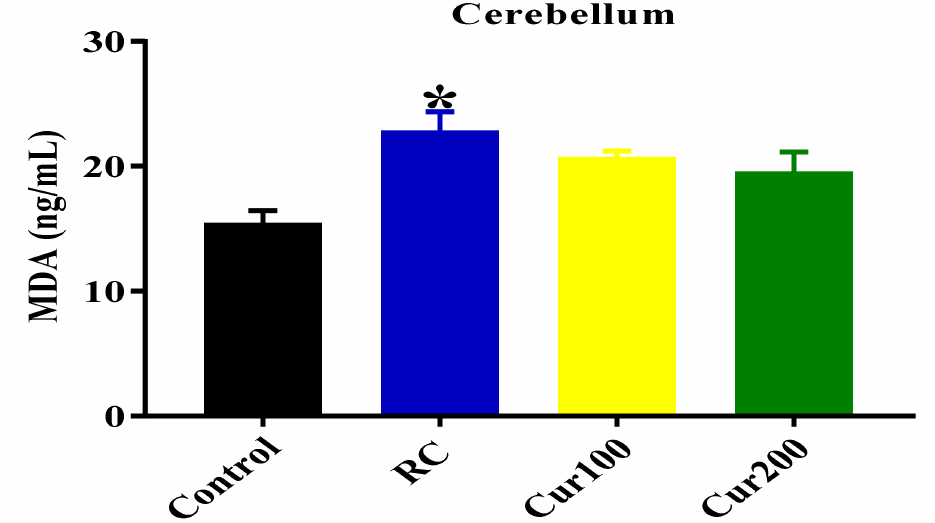
Figure 13. E ff ect of curcumin on malondialdehyde (MDA) levels in the cerebellums of Pb-induced rats. Data are expressed as mean ± SEM ( n = 3); * p < 0.05 vs.